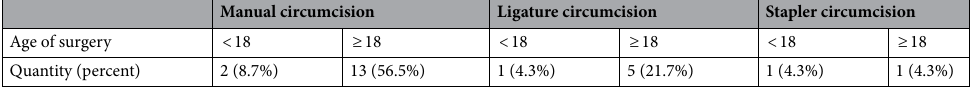
Table 5. The age at surgery and the occurrence of secondary epidermoid cysts of the penis. Among the people who developed secondary epidermoid cysts of the penis after surgery, whether it was the total proportion or the proportion after different surgical procedures, the proportion of adult patients was the highest.